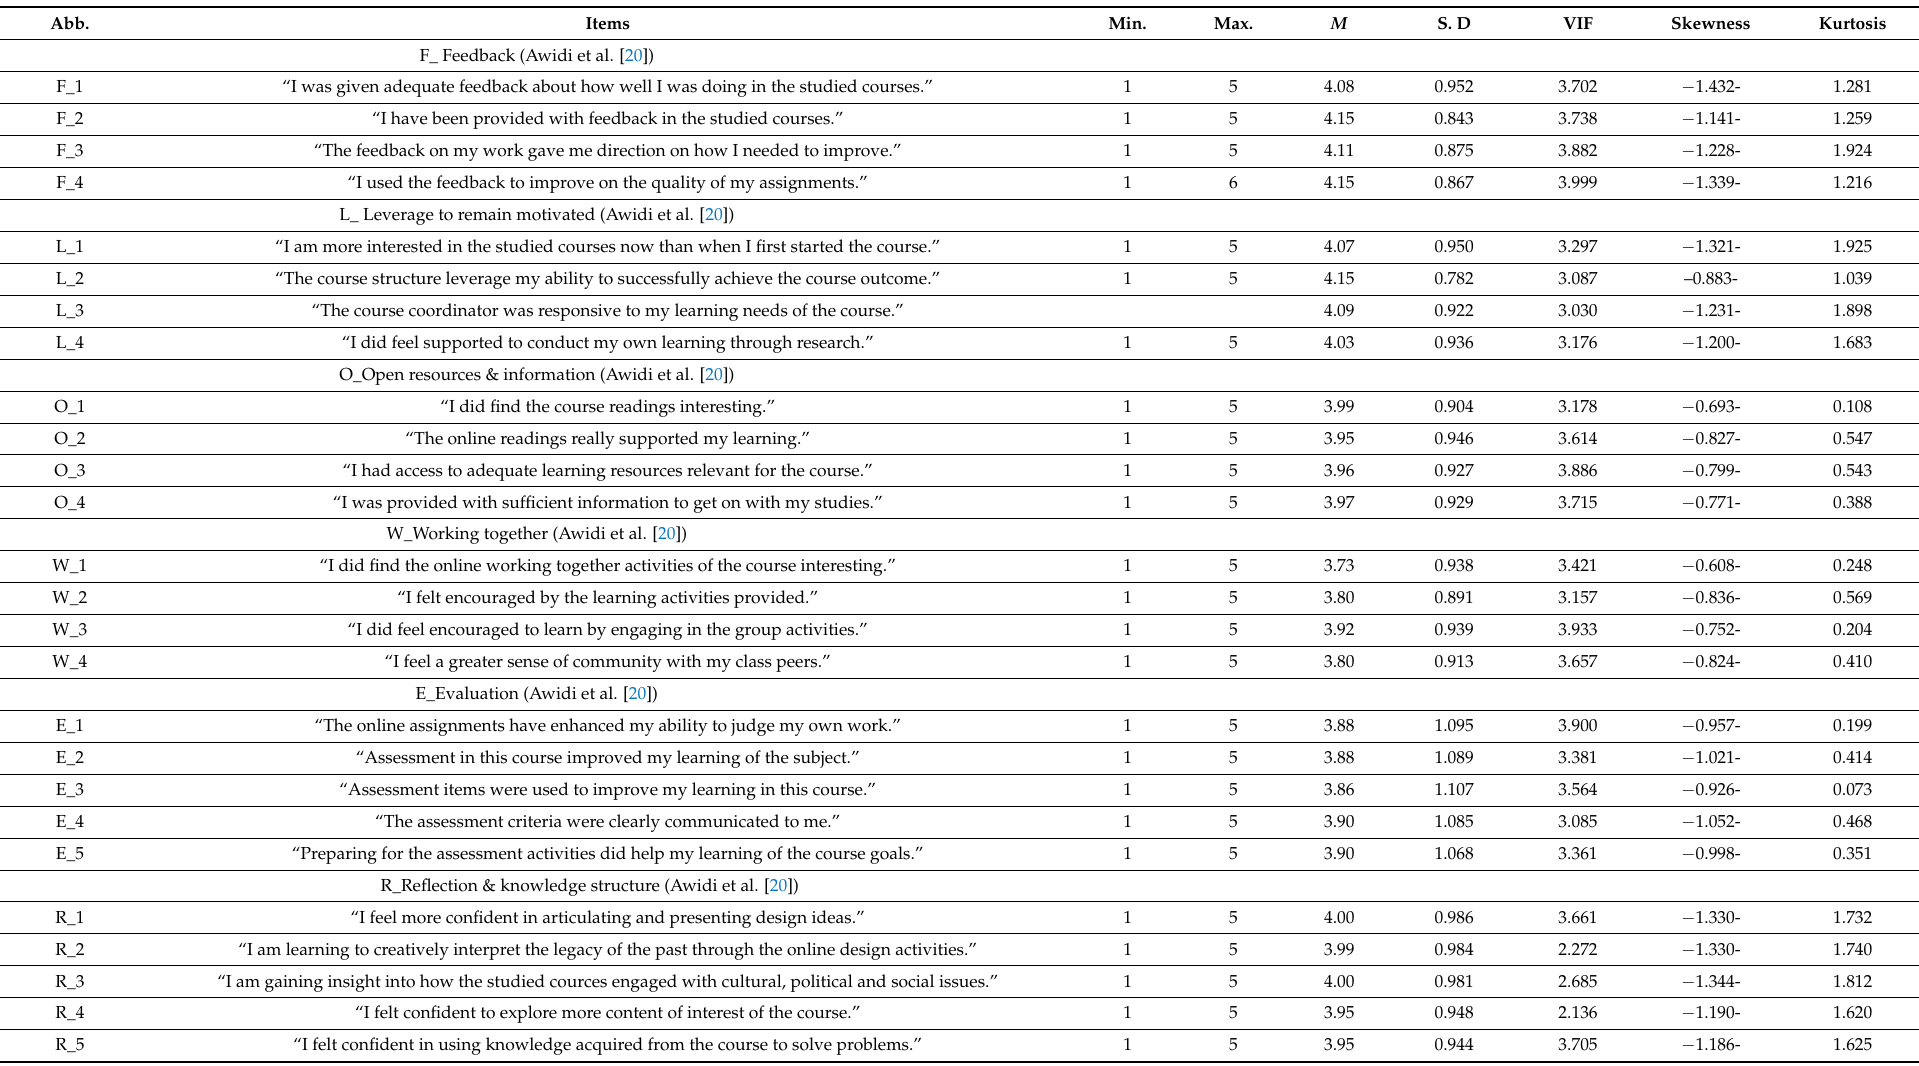
Table 1. Descriptive analysis ( n =